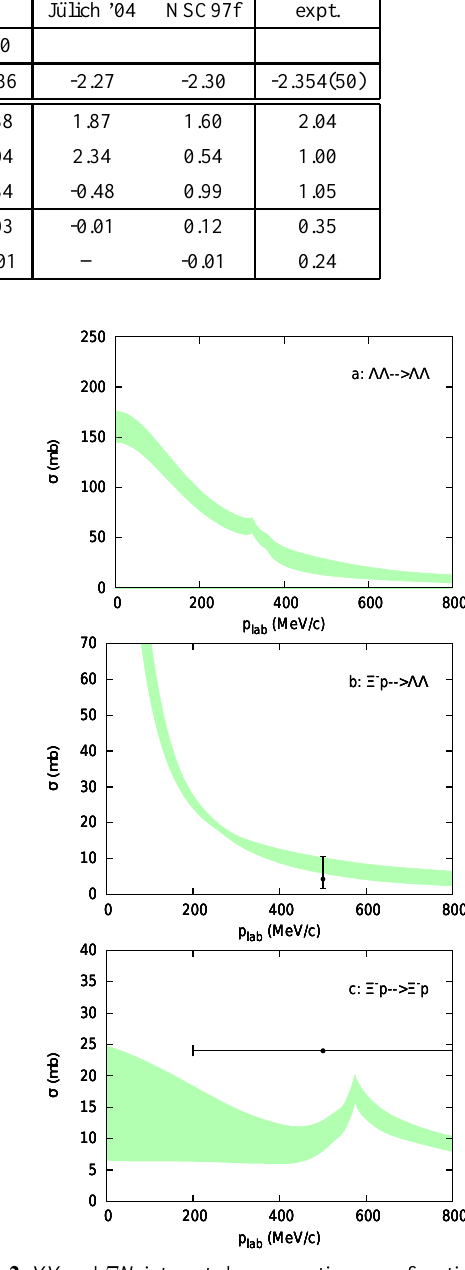
Fig. 2. YY and Ξ N integrated cross sections as a function of p lab . The band shows the chiral EFT for variations of the cuto ff Λ as discussed in the text. Data are from Ref.